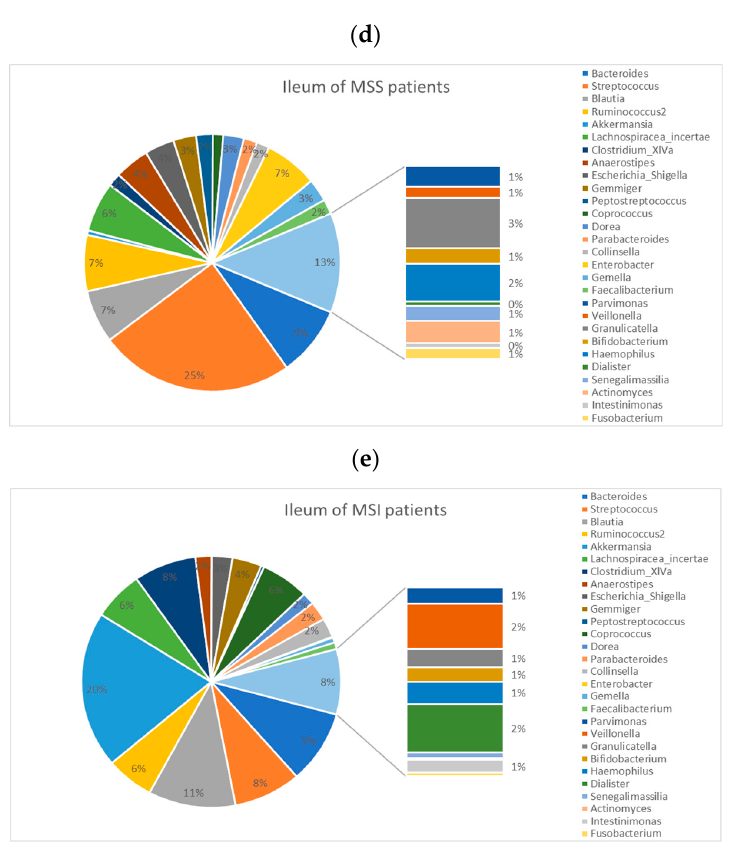
Figure 9. The ileal microbiome profile, taxonomic analysis: ( a ) Pie chart of the microbiome abundance profile of the terminal ileum. The inner circle represents the family level, and the outer circle represents the genus level. Microbiome profiles classified according to tumor location and MSS status: RSCC ( b ), LSCC ( c ), MSS ( d ) and MSI ( e